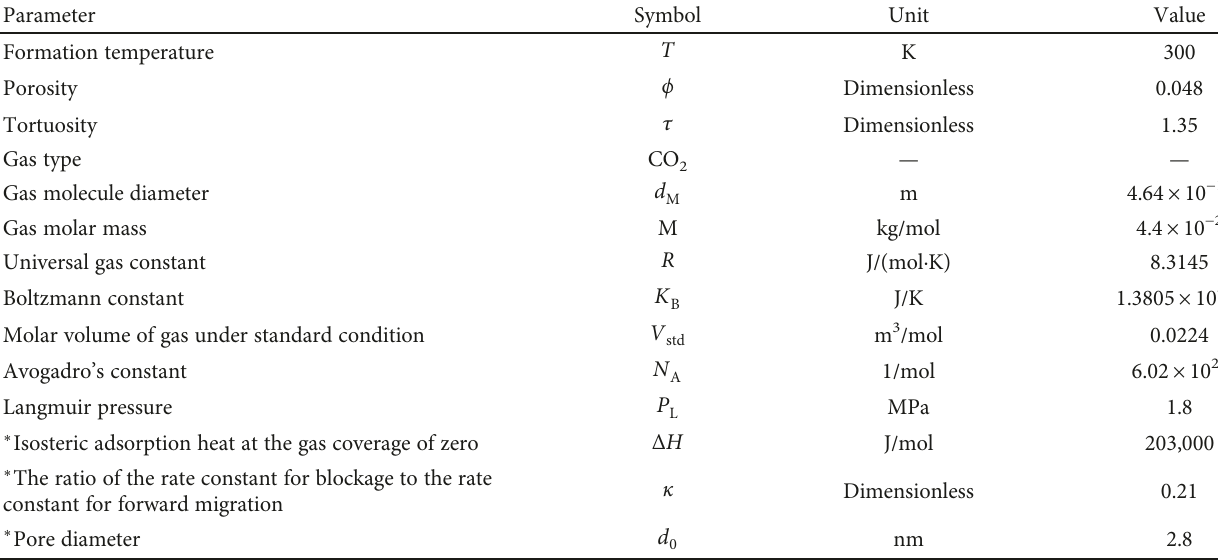
Table 1: Parameters for the validation case.